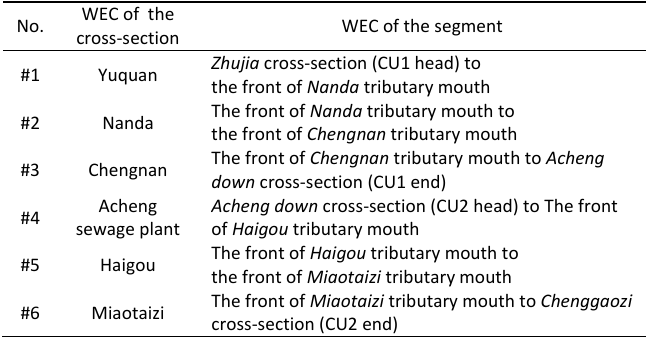
Table 5: The equivalence relationship of WEC at the cross ‐ section and the segment No.